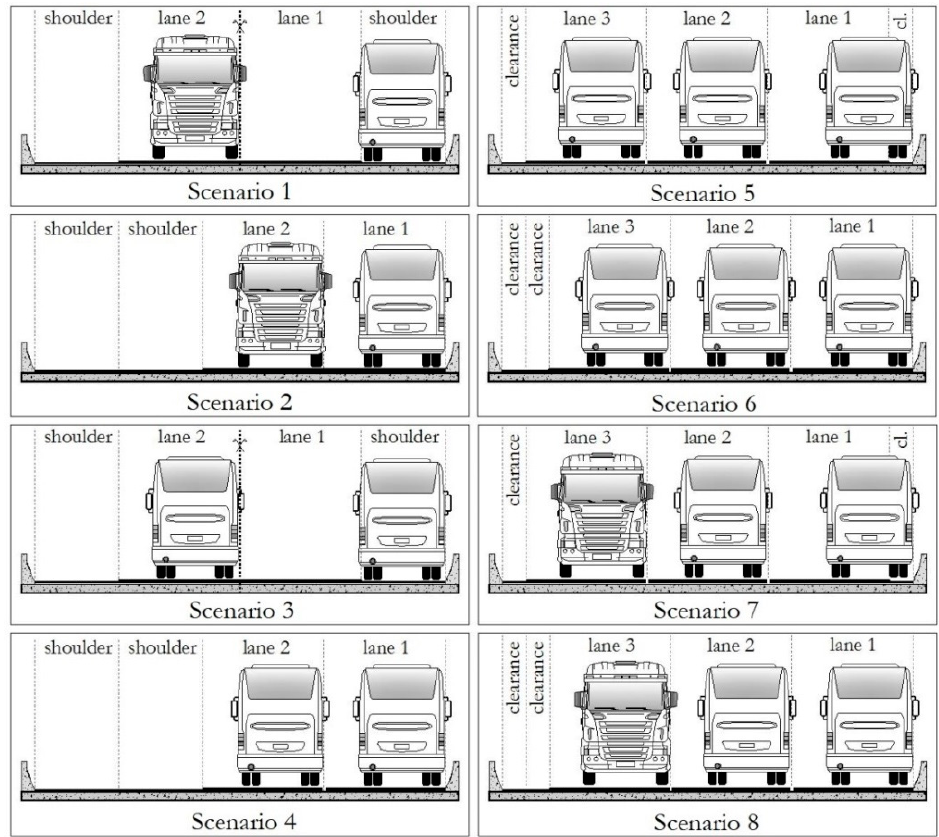
Figure 5. Traffic scenarios considered for the Ultimate Limit State design [30].